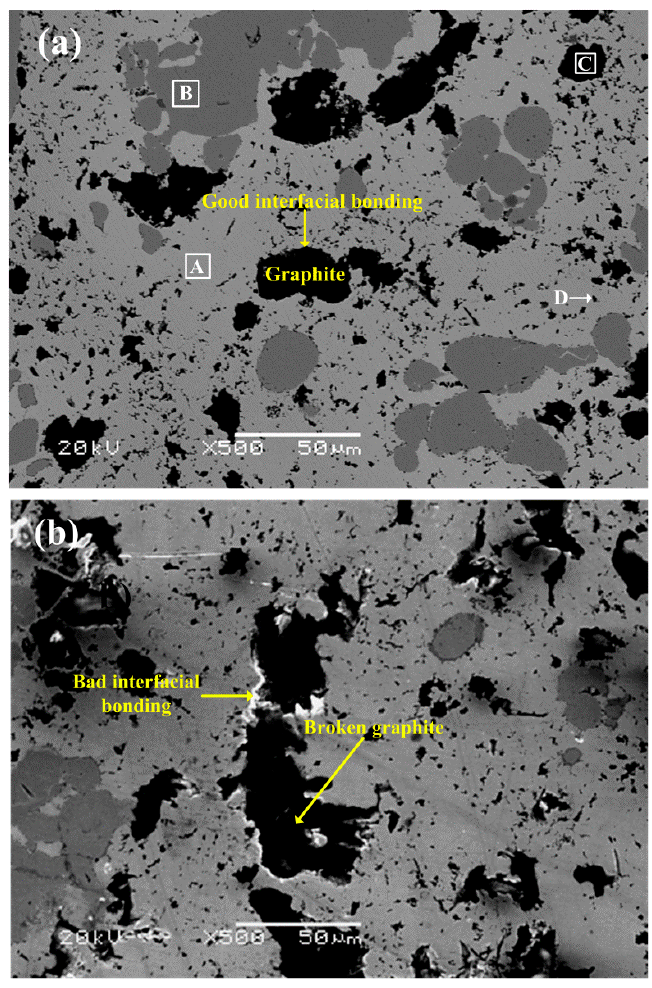
Figure 5. Microstructures of specimen S1 ( a ) and S2 ( b ). Table 3. EDS analysis results of area A, B, C, and D in Figure 5a.